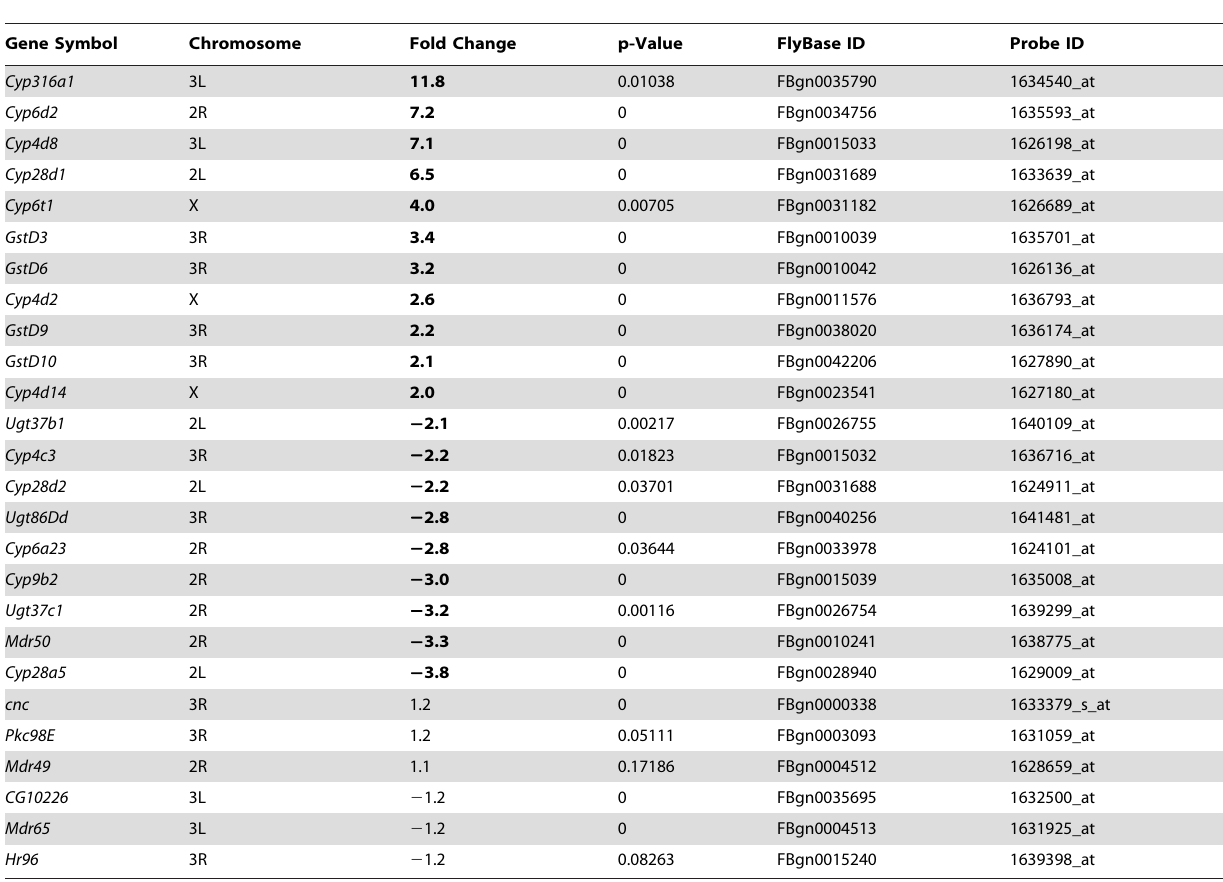
Table 2. Single gene analysis for Ama-KTT/M/2 on a -amanitin versus Ama-KTT/M/2 on no toxin (group 3 versus 2).